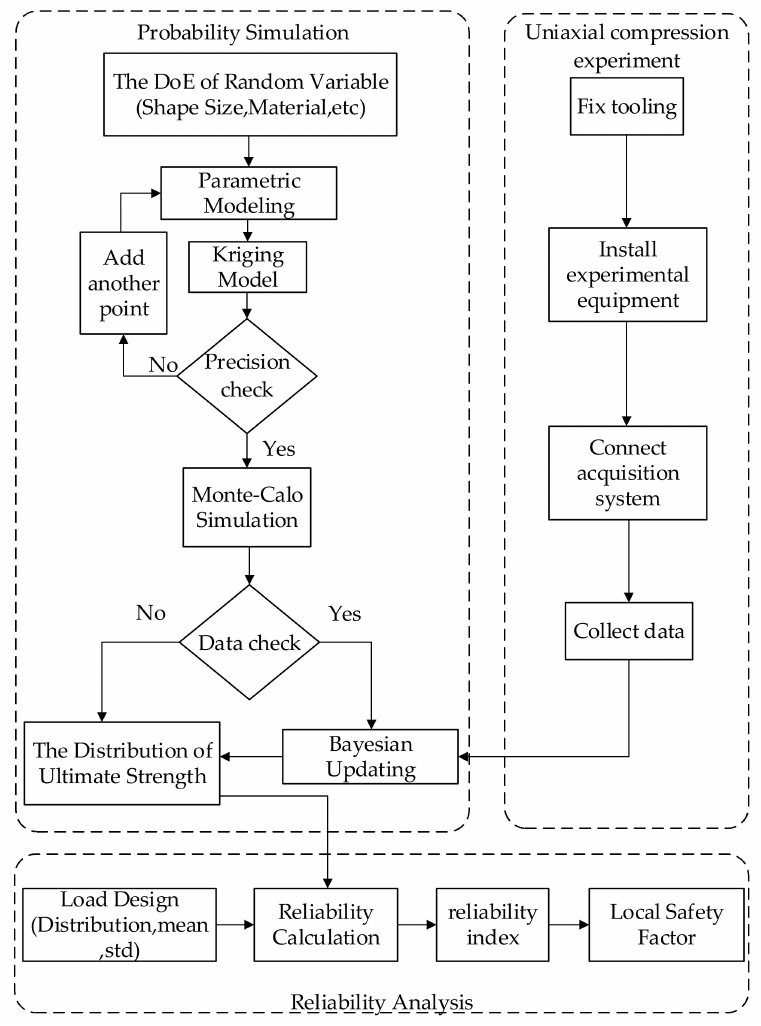
Figure 2. Flow chart of reliability analysis